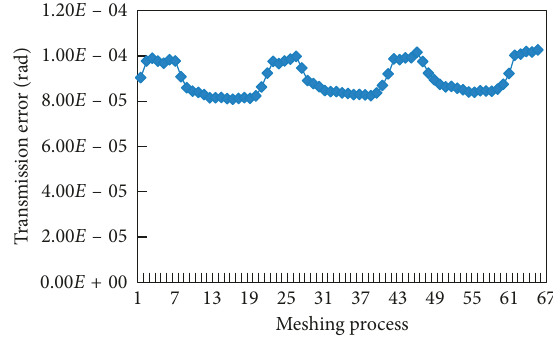
Figure 5: Curve of transmission